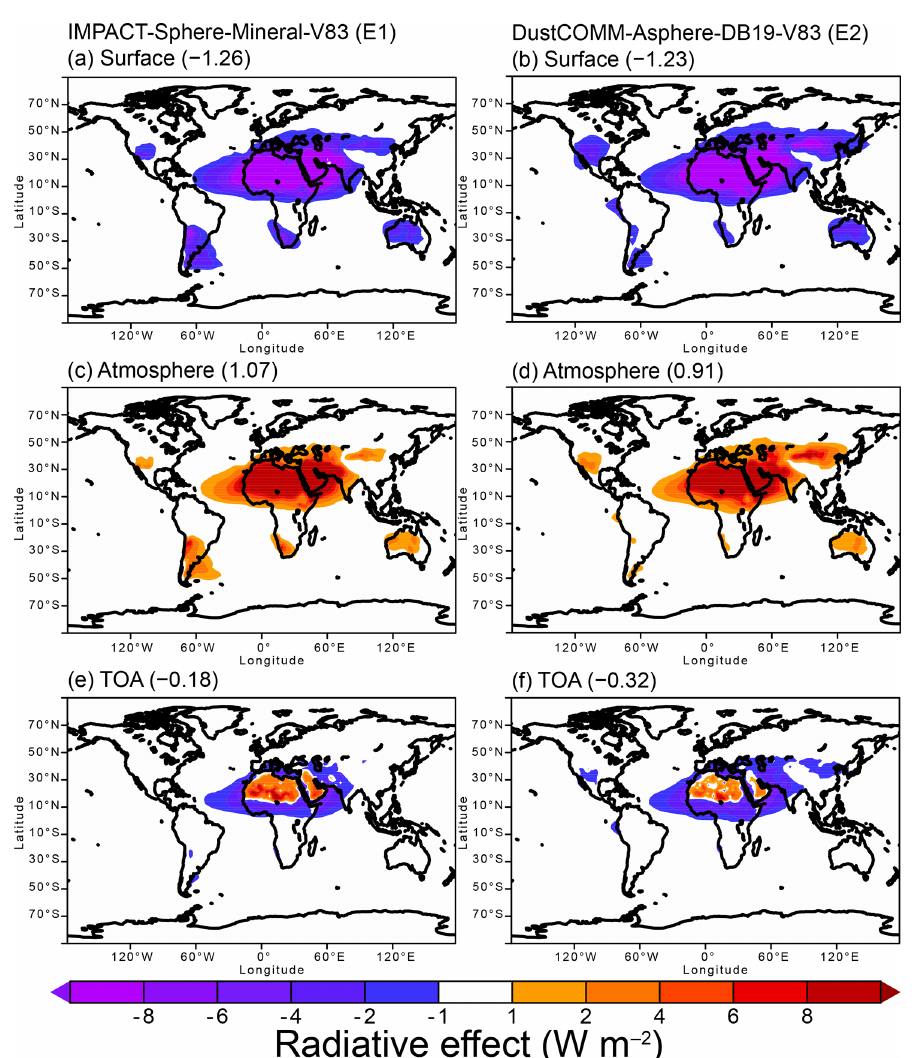
Figure 6. Dust SW radiative effect (Wm − 2 ) and radiative heating of the atmosphere (i.e., the subtraction of radiative effects from TOA to the surface in units of Wm − 2 ). The model results are shown for the simulations for (a) IMPACT-Sphere-Mineral-V83 (E1) at the surface, (b) DustCOMM-Asphere-DB19-V83 (E2) at the surface, (c) E1 in atmospheric column, (d) E2 in atmospheric column, (e) E1 at TOA, and (f) E2 simulations at TOA. The numbers in parentheses represent the global